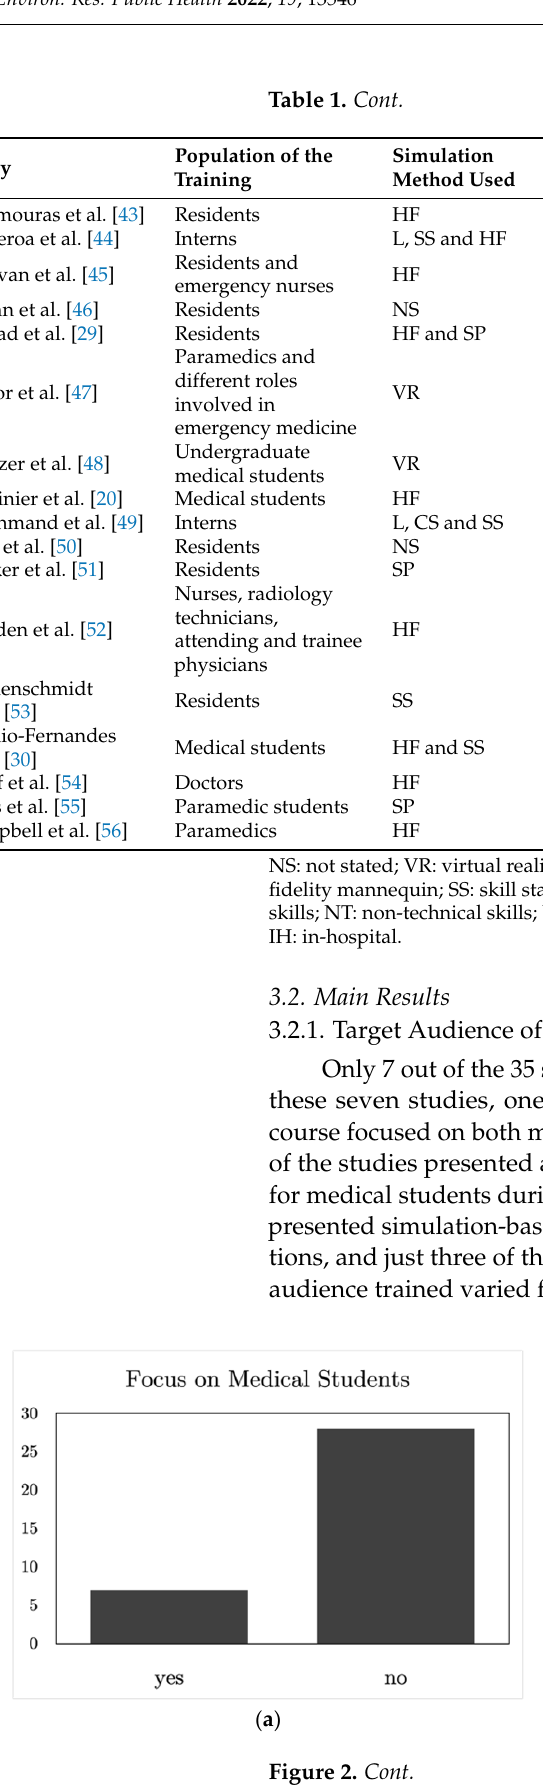
( f ) Figure 2. Results of the different aspects highlighted in this scoping review: ( a ) the focus on medical students of the trainings, ( b ) the use of high-fidelity mannequin simulators, ( c ) the type of skills trained, ( d ) if there is an automated evaluation process, ( e ) the type of evaluation used in the train- ing, and ( f ) the context in which the simulation focuses. 3.2.2. Simulation Methods Used With respect to the simulation methods used during the simulation-based training courses analyzed, 18 of them (51.4% of the training courses) used high-fidelity manne- quins during the trainings, as shown in Figure 2b, whereas the rest used any other meth- ods. Regarding the other methods used, one of them presented simulation cards as the training method used; three of them used standardized patients trained for that purpose; another three studies used skill stations to practice several skills during the trauma man- agement training; and seven of them used virtual reality training as the simulation method. This virtual reality modality included an immersive experience, in which VR